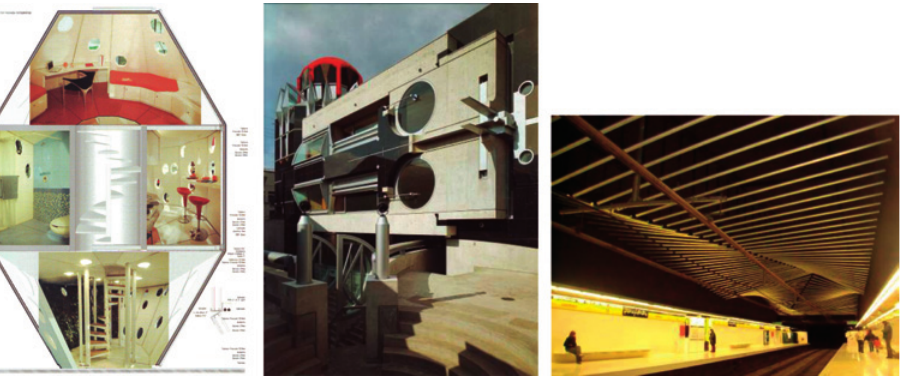
Fig. 15. Broissin Fig. 16. Shin Takamatsu. Fig. 17. Carlos Ferrater. Llucmajor Origin III . Kamigyo, Metro Station, Barcelona Note: A linear element is repeated through an axis, while at the same time it is gradually rotated. This is the mental idea that this structure causes in